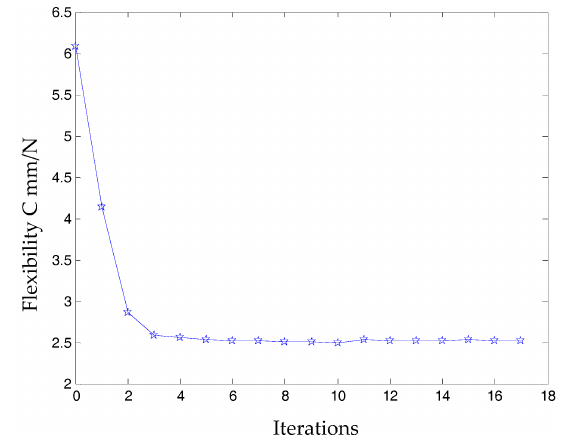
Figure 6. Topology optimization iteration procedure of 3-PRR planar fully CPM.